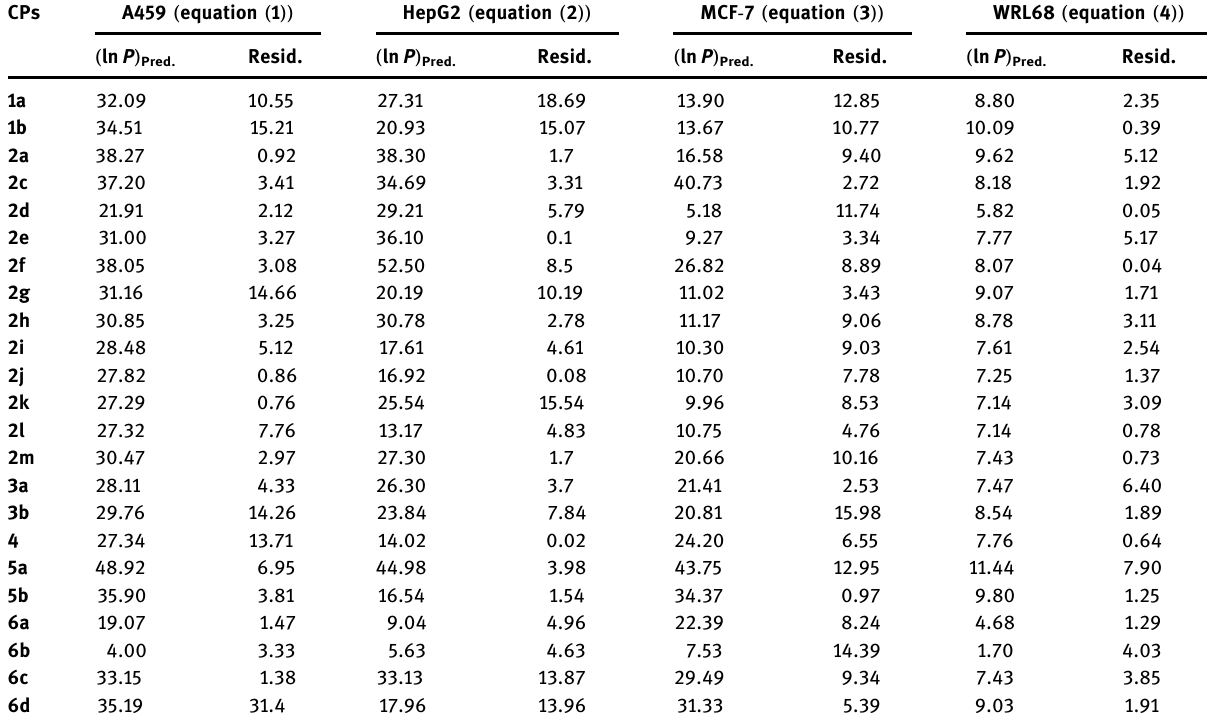
Table 8: Predicted percentage inhibition and residuals obtained by using MLR equations ( 1 ) – ( 4 ) and considering all compounds CPs A459 ( equation ( 1 )) ( ln P )